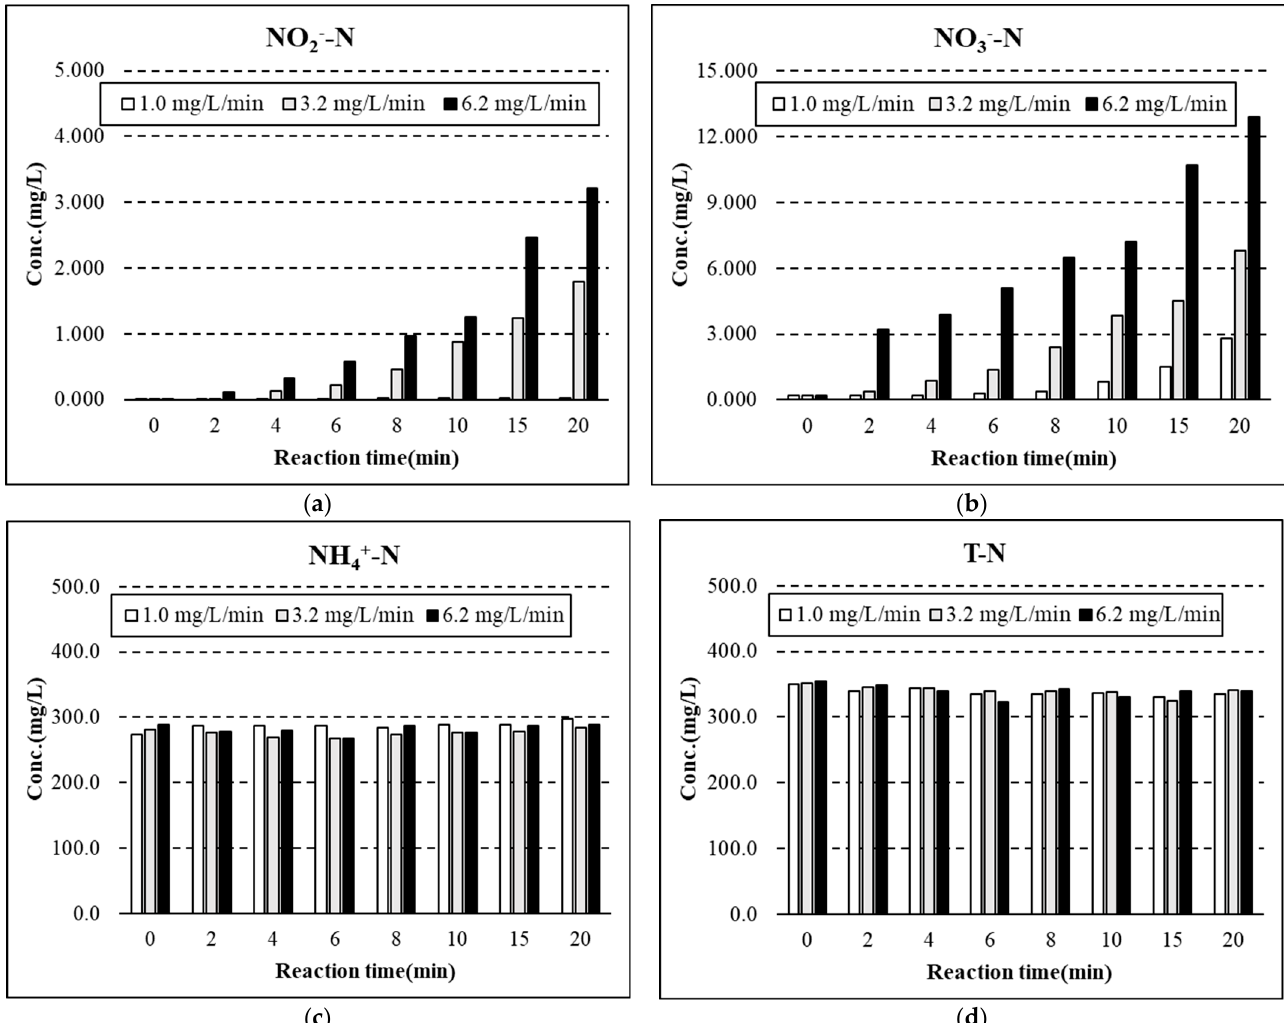
Figure 3. Nitrogen changes by ozone: ( a ) NO 2 − -N, ( b ) NO 3 − -N, ( c ) NH 4+ -N, and ( d ) T-N.